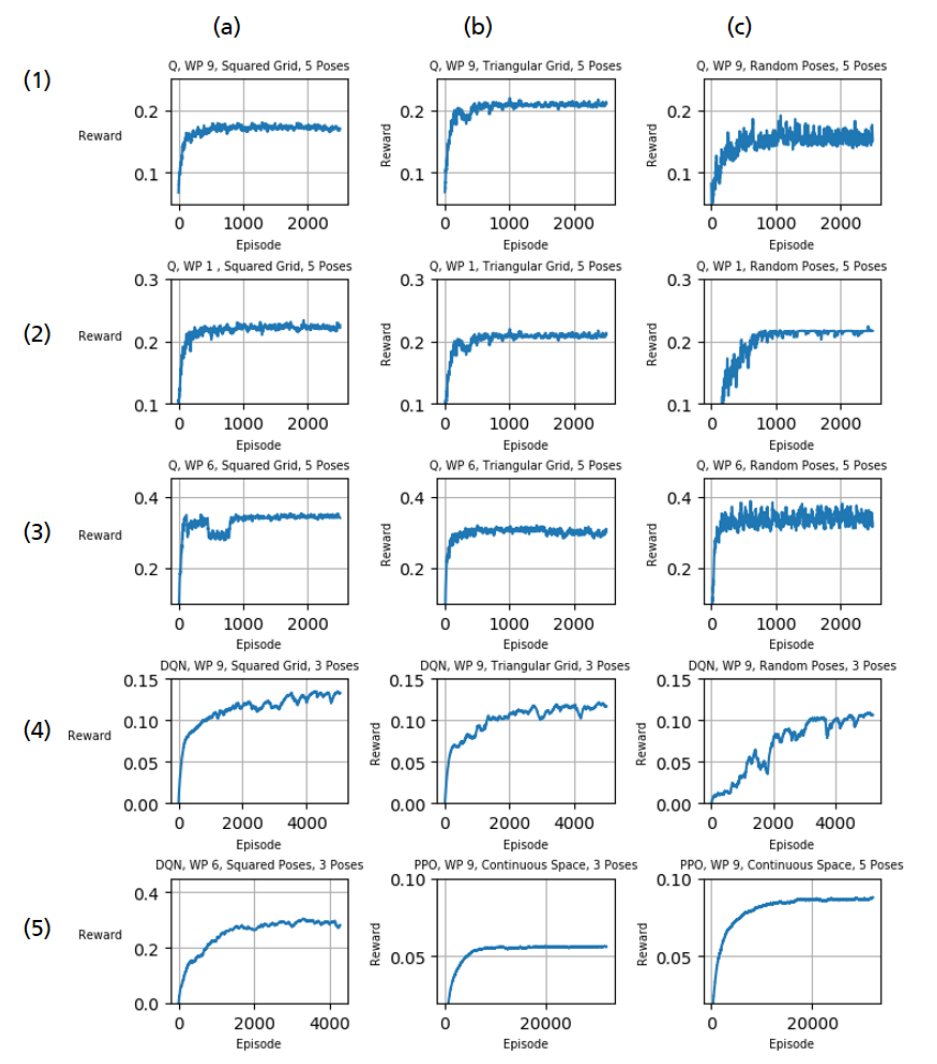
Figure 7. Training results of Q-learning, DQN and PPO using different action spaces (squared grid, triangular grid, random poses, or continuous) and trained on three different workpieces as denoted above each